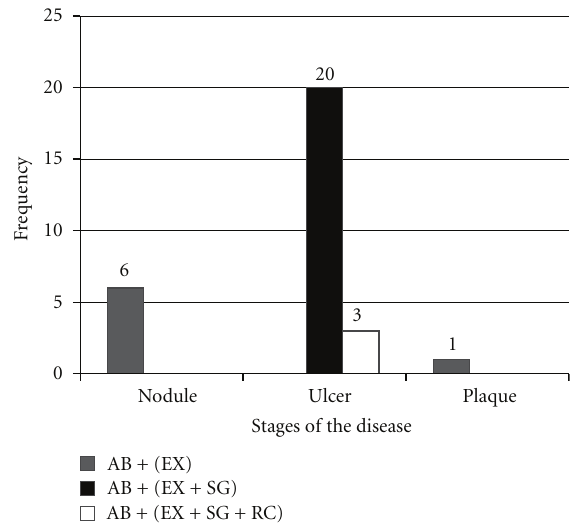
Figure 3: Stages of the disease and treatment received by patients.